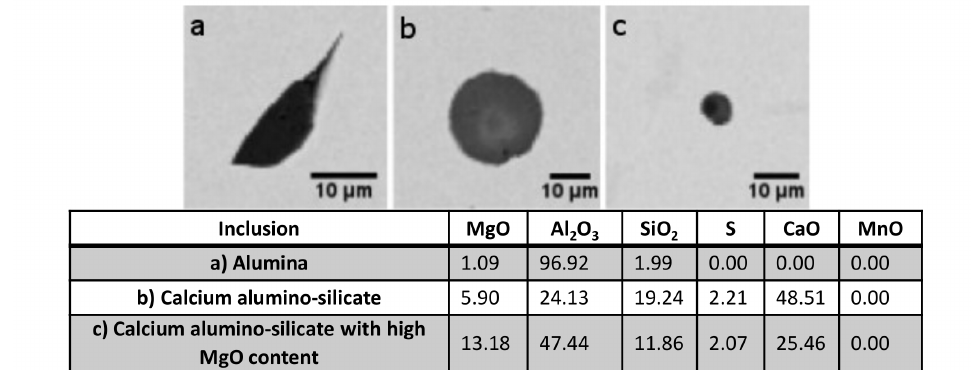
Figure 12. Morphology and typical inclusions of some heats